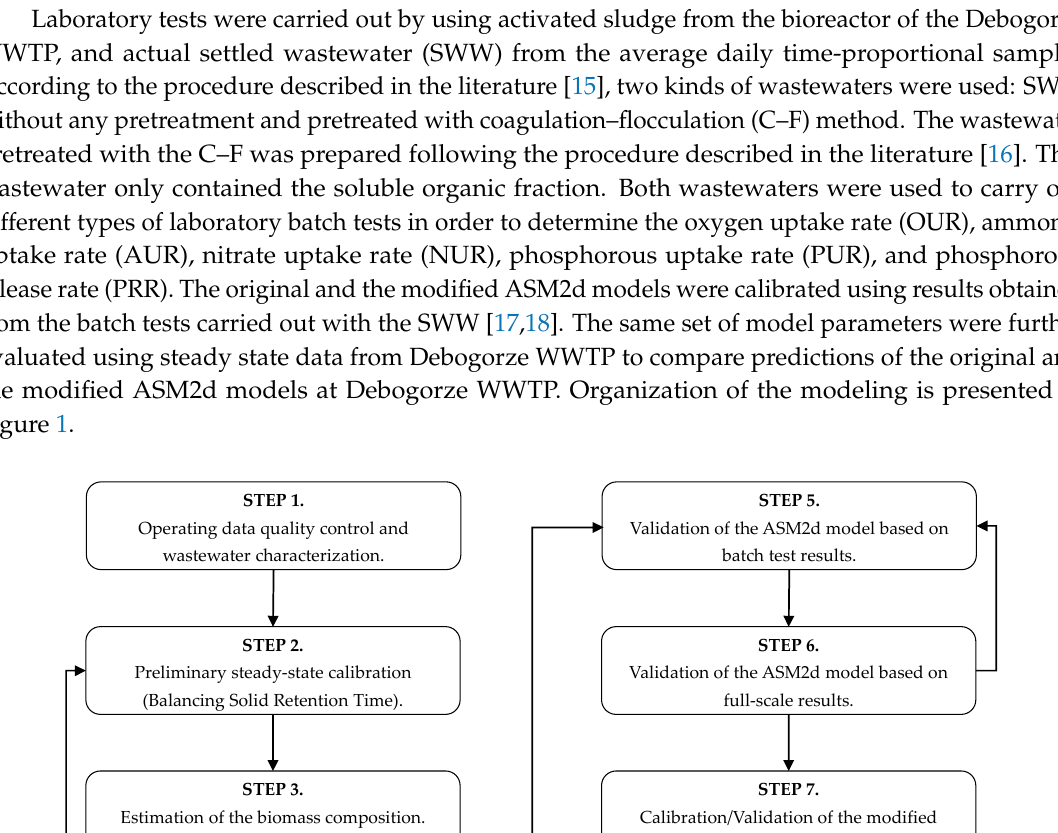
Table 1. C haracteristics of the influent wastewater during studied periods at Debogorze WWTP